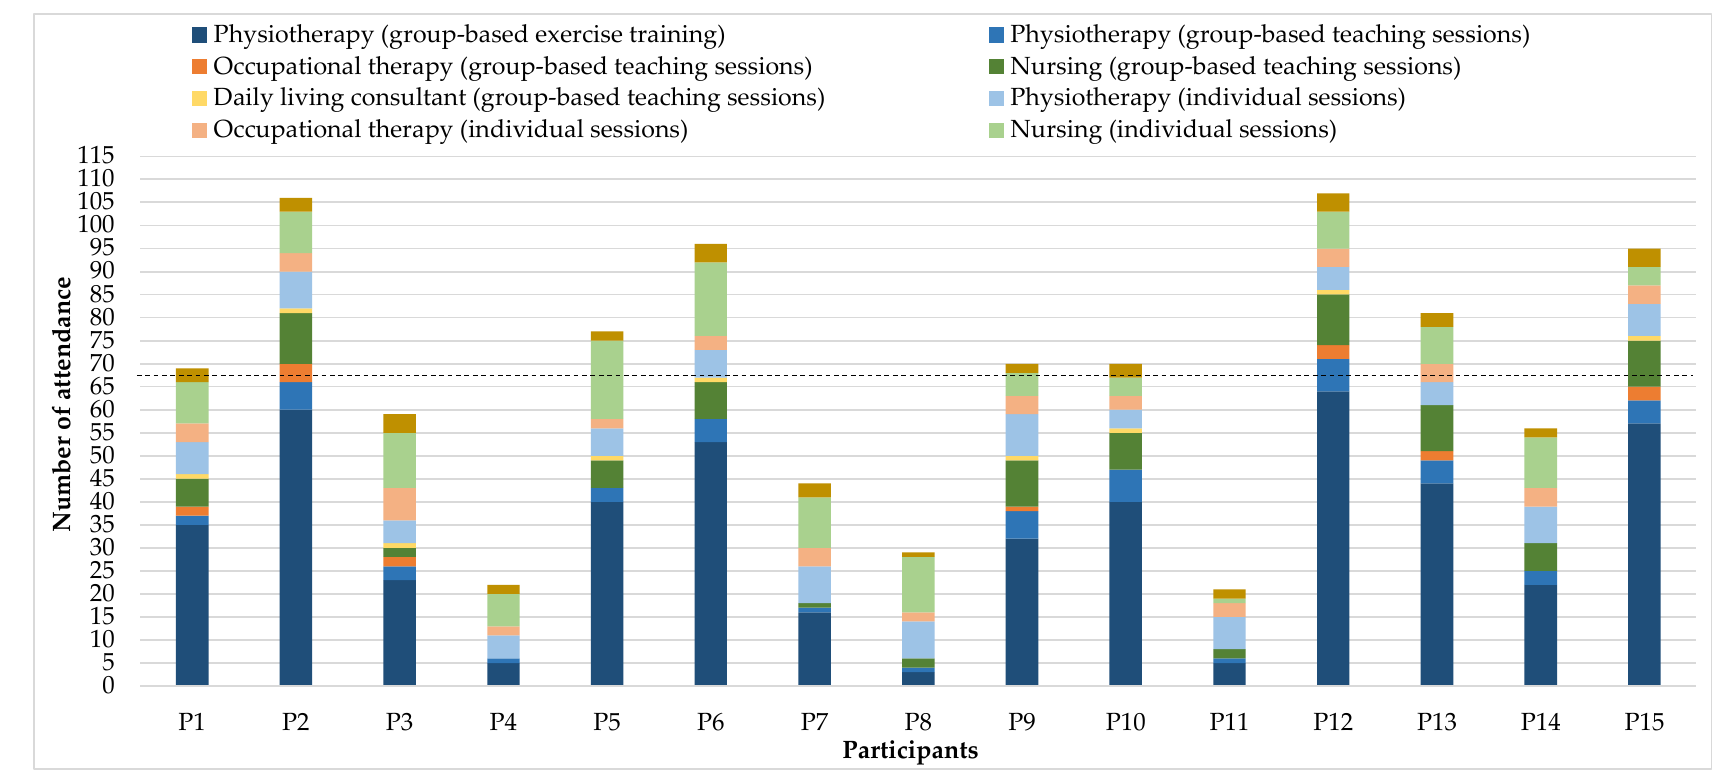
Figure 6. Participation in >C  PD-Life>> .